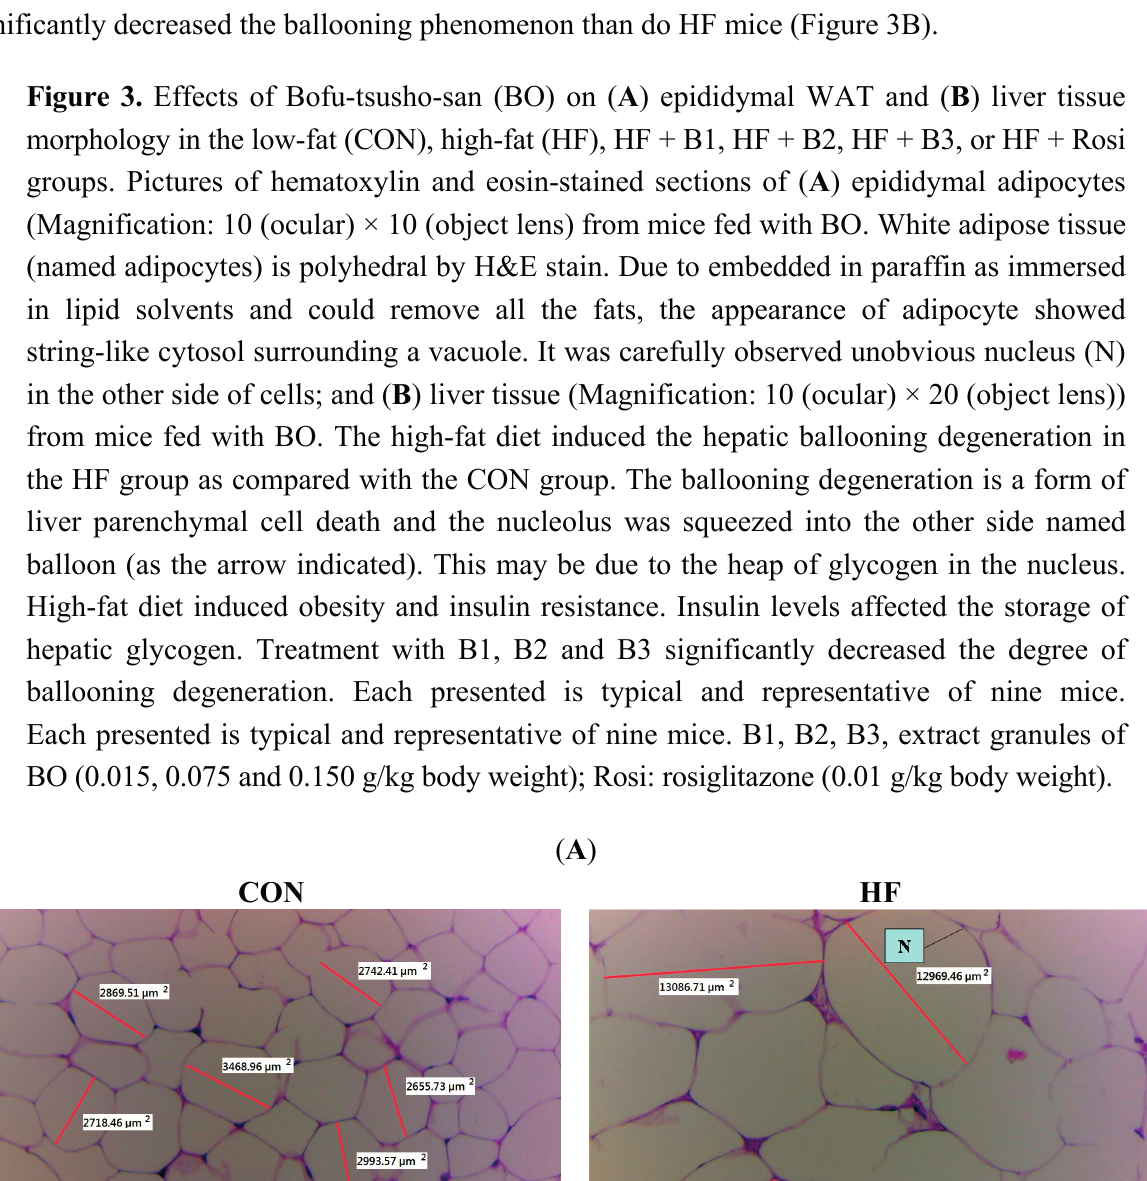
Figure 3. Effects of Bofu-tsusho-san (BO) on ( A ) epididymal WAT and ( B ) liver